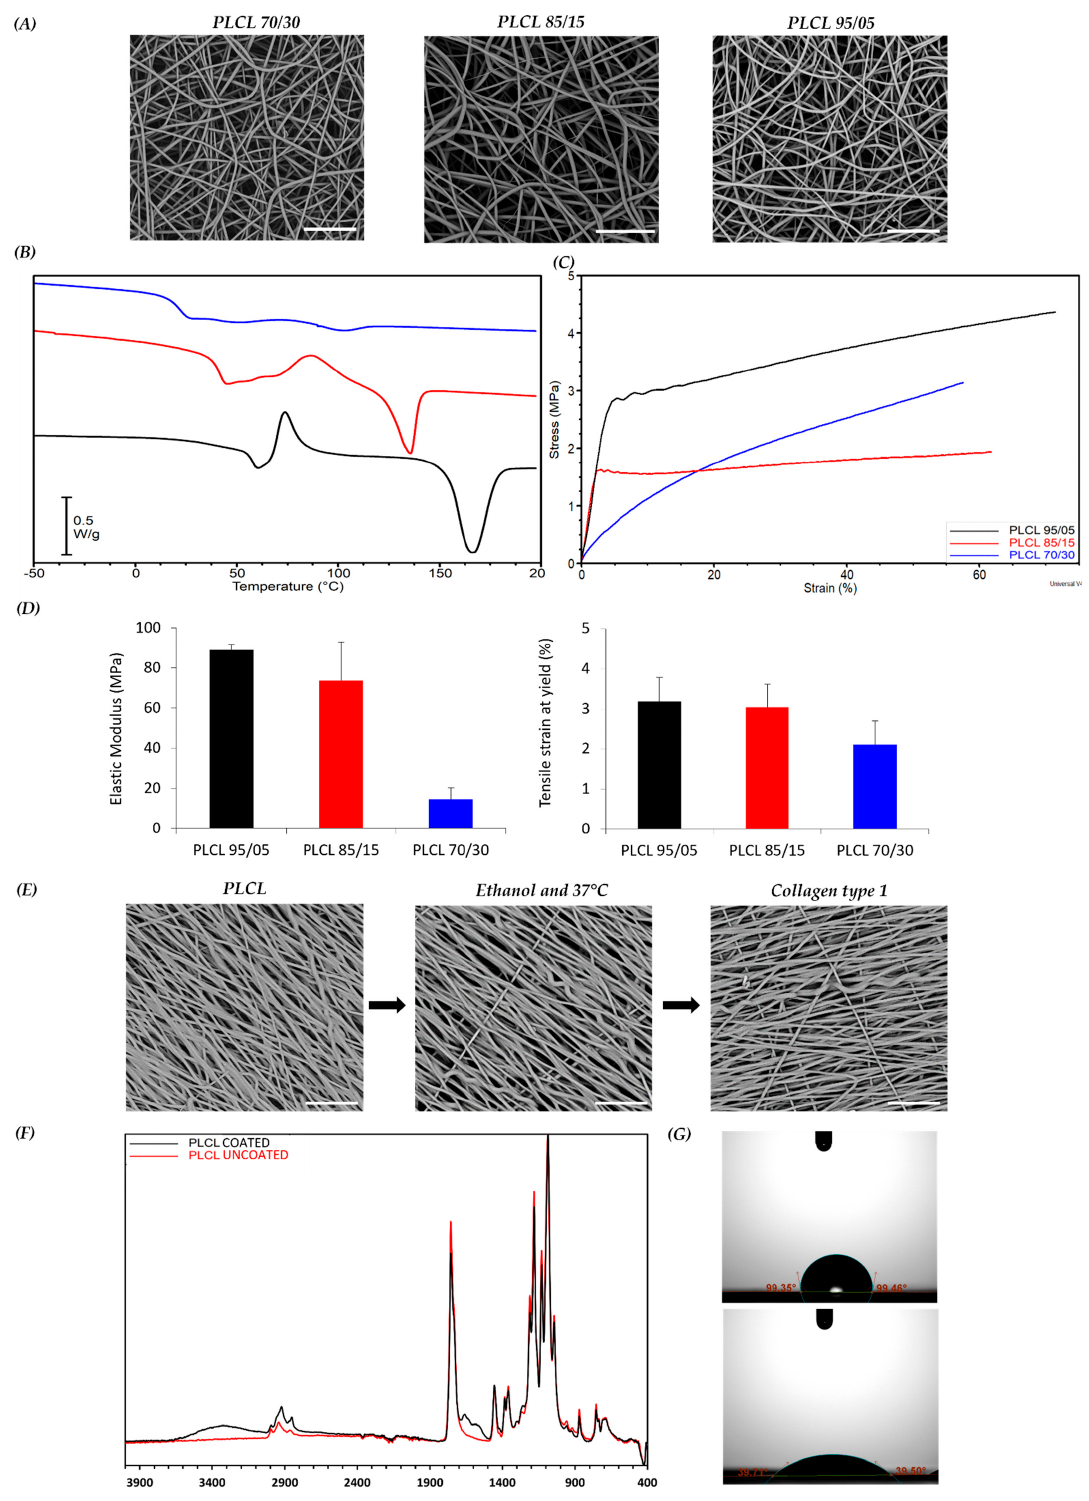
Figure 1. Scaffold characterization. ( A ) SEM micrographs of scaffolds: PLCL 70/30 (blue), 85/15 (red) and 95/05 (black). ( B ) DSC heating ramp of scaffolds and glass transition temperature (T g ). ( C ) Representative stress-strain curves of scaffolds. ( D ) Young’s modulus and yielding points of scaffolds. ( E ) SEM micrographs of PLCL 70/30 scaffold after sterilization with ethanol, treatment at 37 ◦ C and coating with type I collagen. ( F ) ATR-IR spectra of coated and uncoated PLCL mats. ( G ) WCA measurements for uncoated ( top ) and coated ( bottom ) PLCL mats. Scale bars: 20 µ